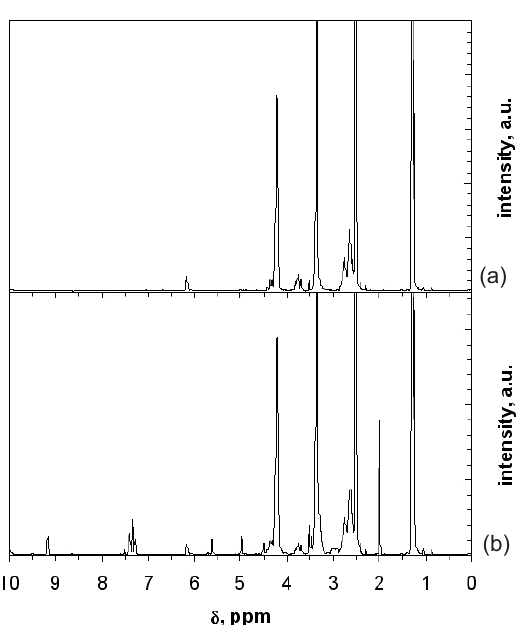
Figure 3. Representative size distributions of (a) PECA, and (b) CPX-PECA colloidal nanospheres. The size distributions are determined by DLS (solid line) and SEM (bars).